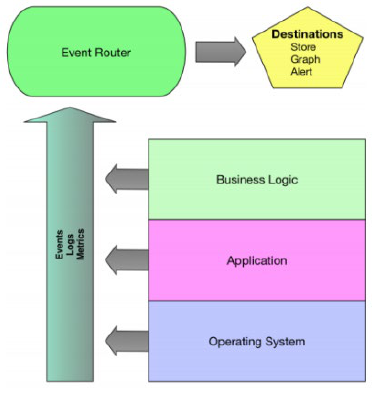
Figure 3. Monitoring Framework